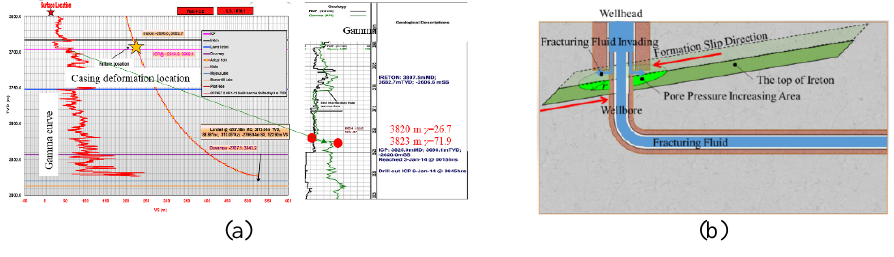
Fig. 3. Logging curve and fault slip